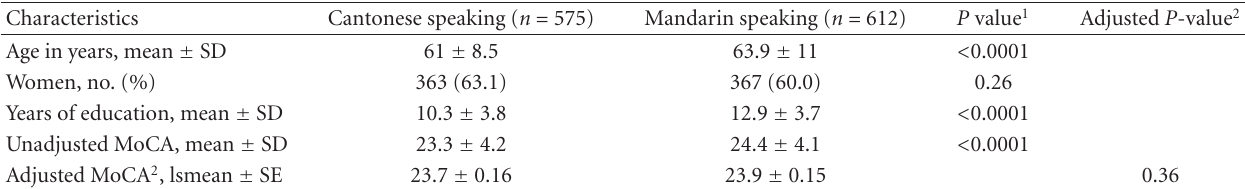
Table 2: Comparisons of age, gender, education, and MoCA-ChLA scores between Cantonese and Mandarin speakers.